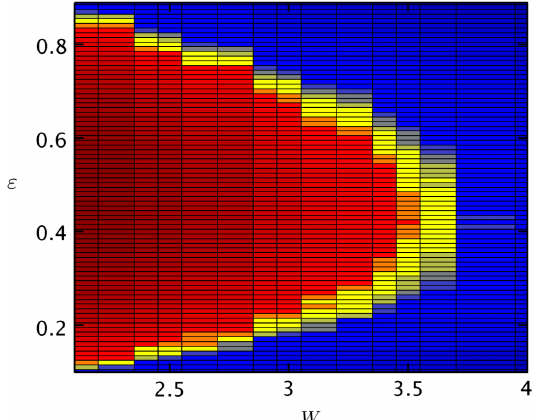
FIG. 4. Many-body mobility edge ε ð W Þ as a function of disorder. The blue (red) color indicates regions where h G ð ε ; L Þi decreases (grows) with L . Yellow regions correspond to points where we cannot determine the behavior because of error